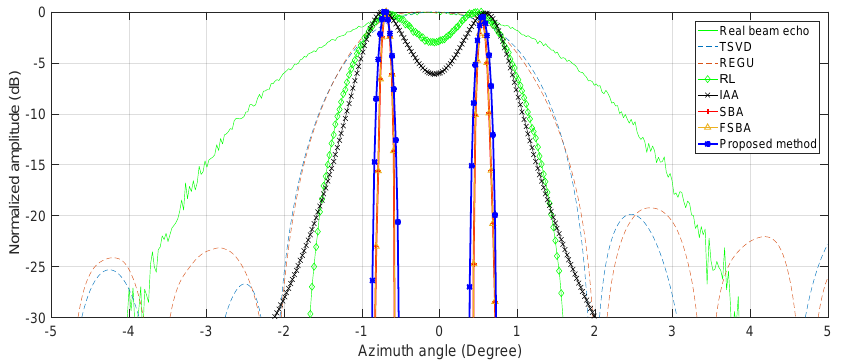
Figure 5. Profiles of adjacent targets.